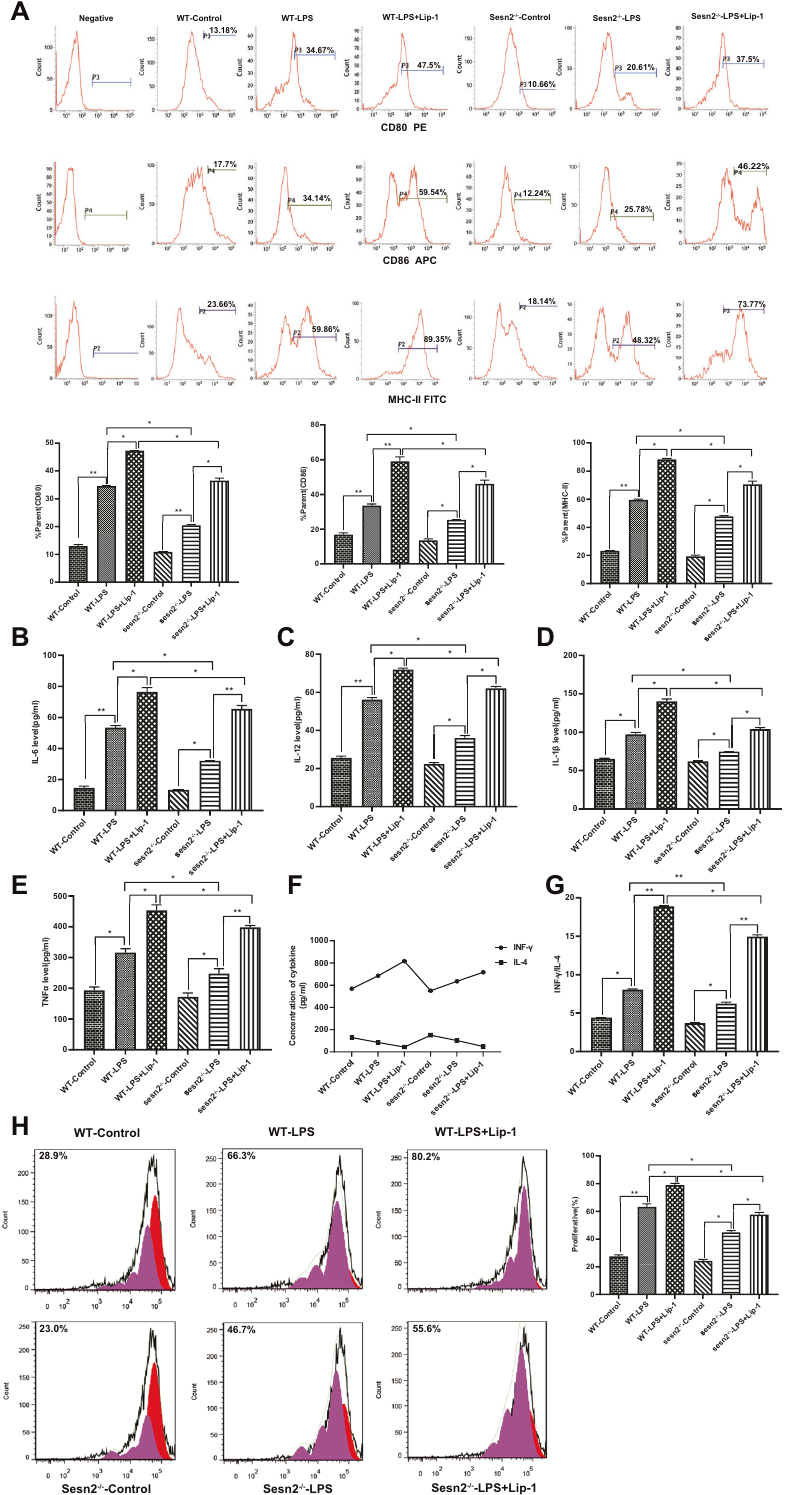
Fig. 4 The protective effect of Sesn2 on DCs is related to the inhibition of ferroptosis. DCs obtained from splenocytes of WT mice and Sesn2 − / − mice, were pretreated with Lip-1 (1 μ M) 1 h prior to LPS stimulation. A Expression of co-stimulatroy phenotypes was determined in murine DCs treated with LPS or pretreated with Lip-1 in advance of LPS. B – E Secretion levels of in fl ammatory cytokines in supernatants from stimulated DCs were assessed by ELISA. F – G CD4 + T cells incubated with Con A were cocultivated with DCs at a ratio of 1:200. Levels of IFN- γ and the IFN- γ /IL-4 ratio were evaluated by ELISA. H Proliferation of CD4 + T cells was examined by CFSE staining after stimulation for 48 h with DCs pretreated with LPS or Lip-1. Values of three independent experiments were expressed as the mean ± SD ( n = 3 per group). Statistical signi fi cance: * P < 0.05, ** P < 0.01 vs. the control